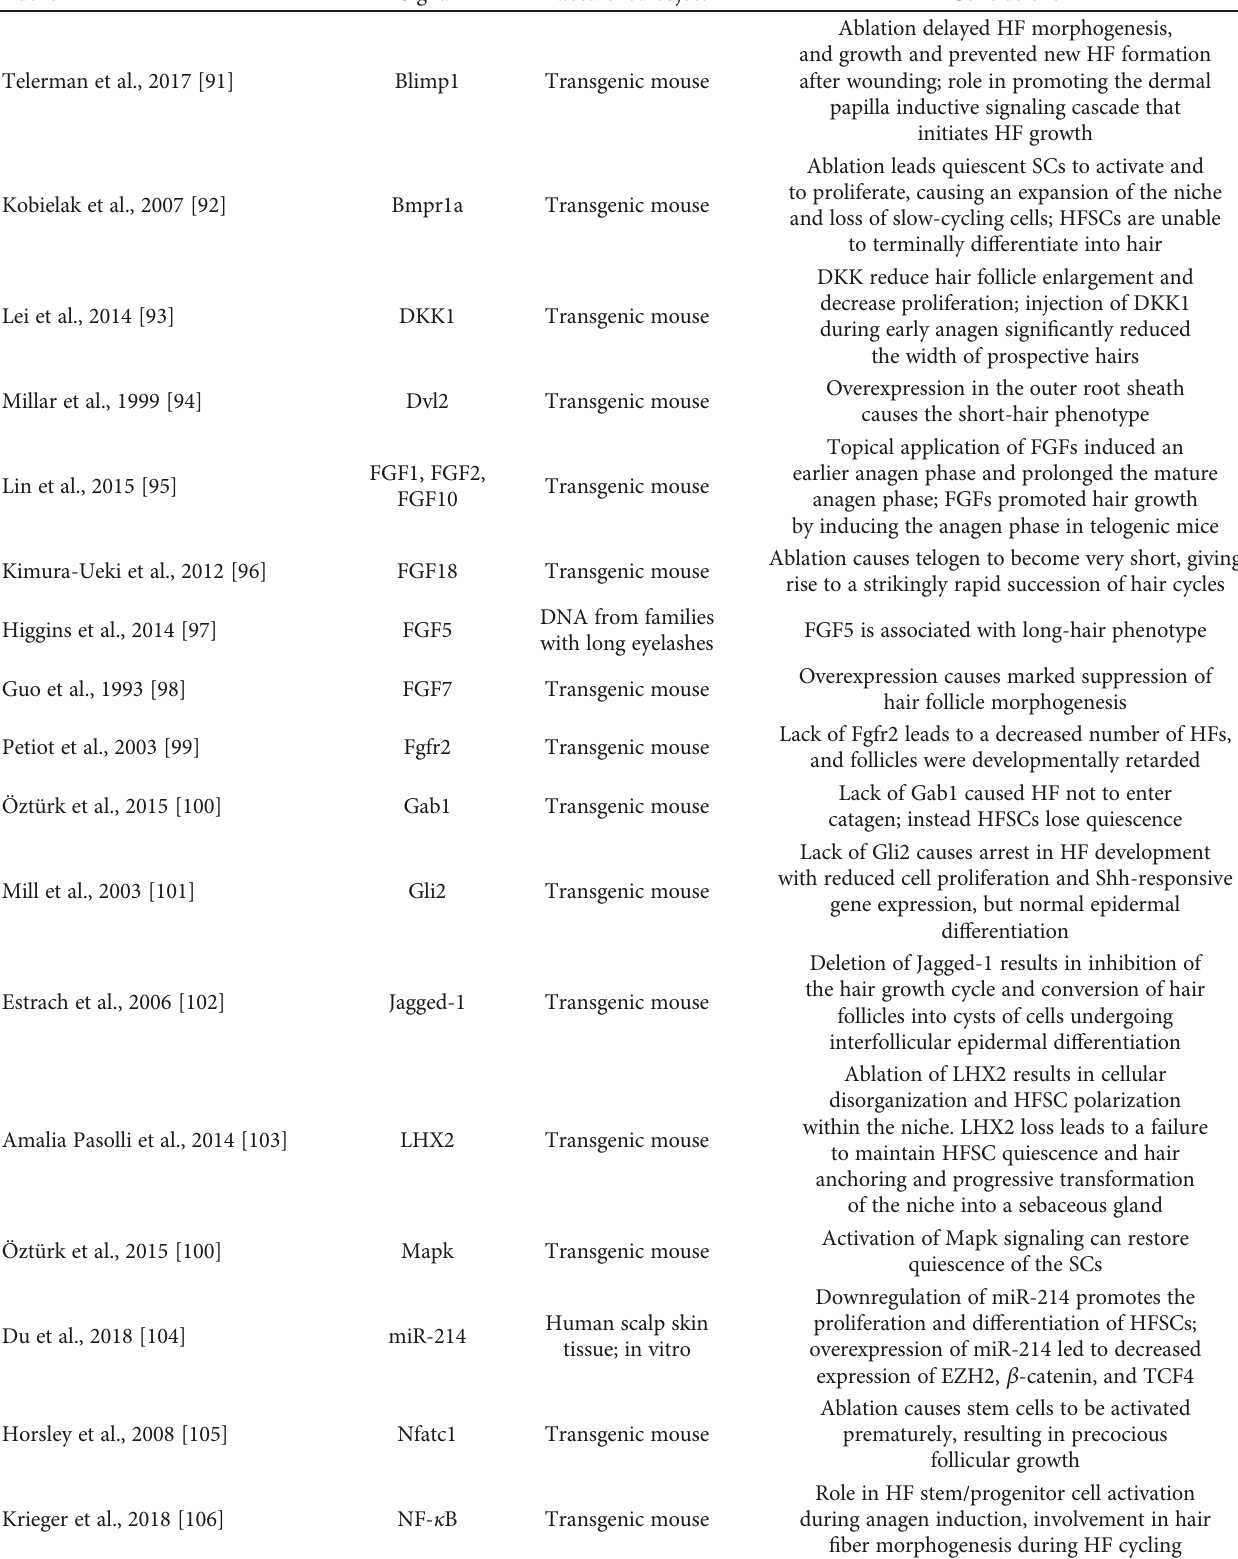
Table 1: The markers of hair follicle and their